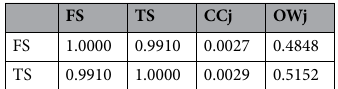
Table 6. Correlation coefficient and calculated